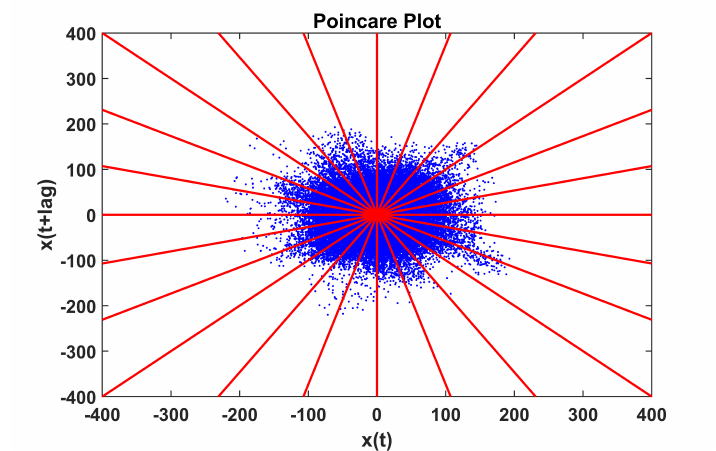
Figure 14. The Poincaré plot is subdivided into 24 angular regions and each region is represented by a symbol.